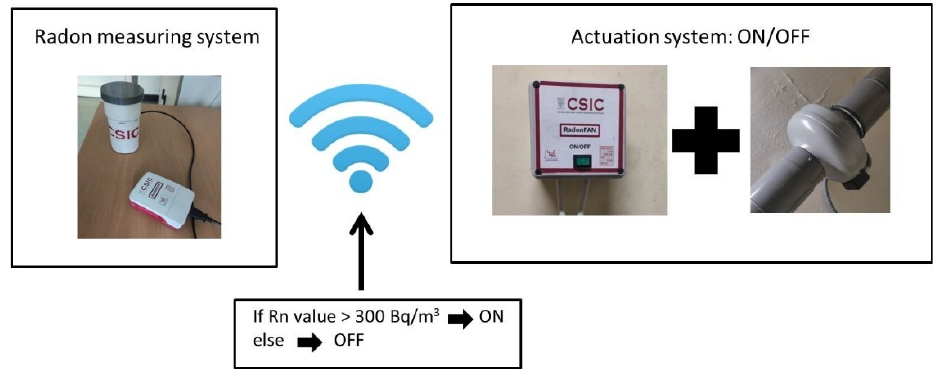
Figure 6. The radon monitoring system developed by the authors.